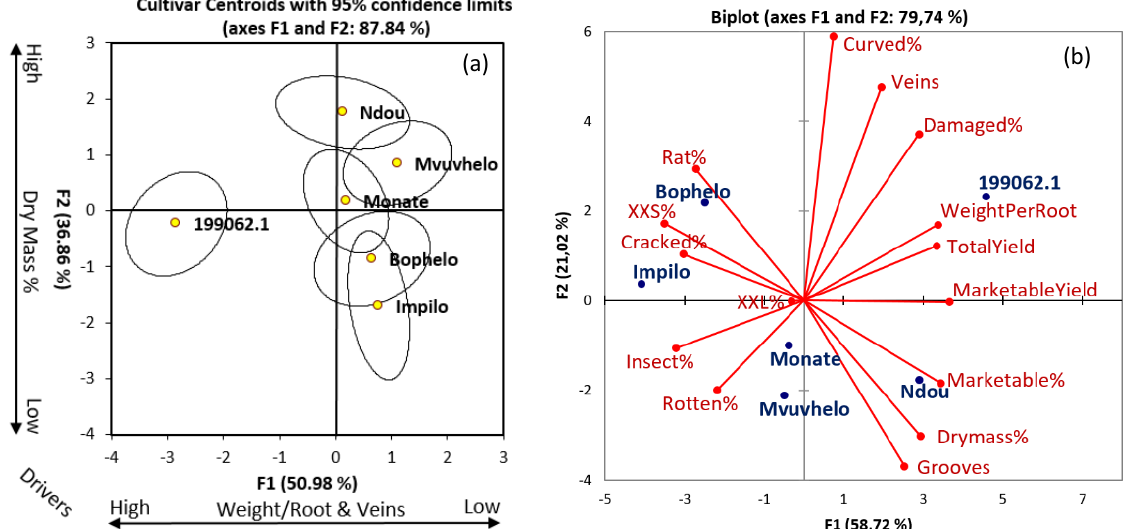
Figure 4: Biplot from a) discriminant analysis showing the association among cultivars and b) principal component analysis (PCA) demonstrating association of variables (loadings) and cultivars (scores) with PCA factor scores